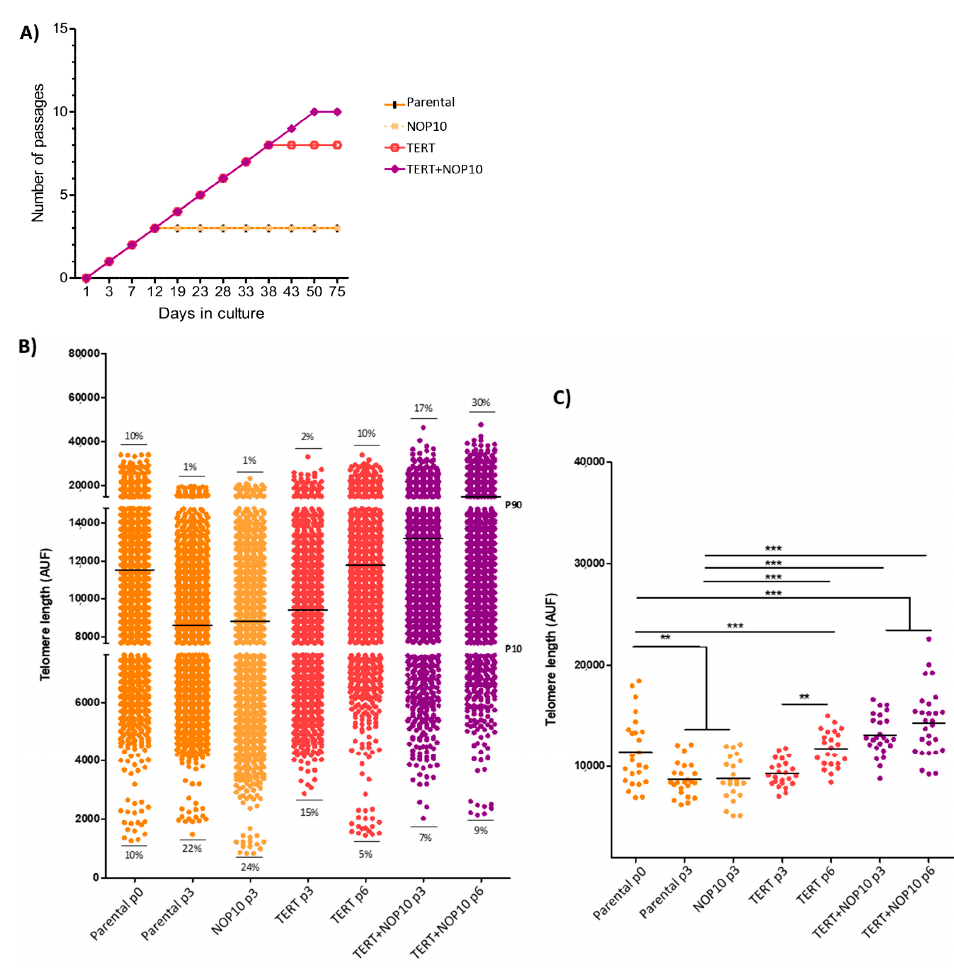
Figure 6. In vitro telomere length analysis. ( A ) Cell proliferation per condition. X axis: number of days in culture since antibiotic selection; Y axis: accumulative number of passages. Parental and NOP10 become quiescent after 3 passages. TERT cells become quiescent after 8 passages and TERT + NOP10 after 10 passages. ( B ) Scatter dot plot showing telomere length. Percentages of short and long telomeres for each isogenic primary culture are shown. Graph separations were made according to percentile 10 and 90 (P10 and P90) based on “Parental p0”. Median telomere length value graphed in black. ( C ) Median telomere length value per cell (one-way ANOVA Tukey’s multiple comparison test: **: p -value < 0.01; ***: p -value < 0.001).